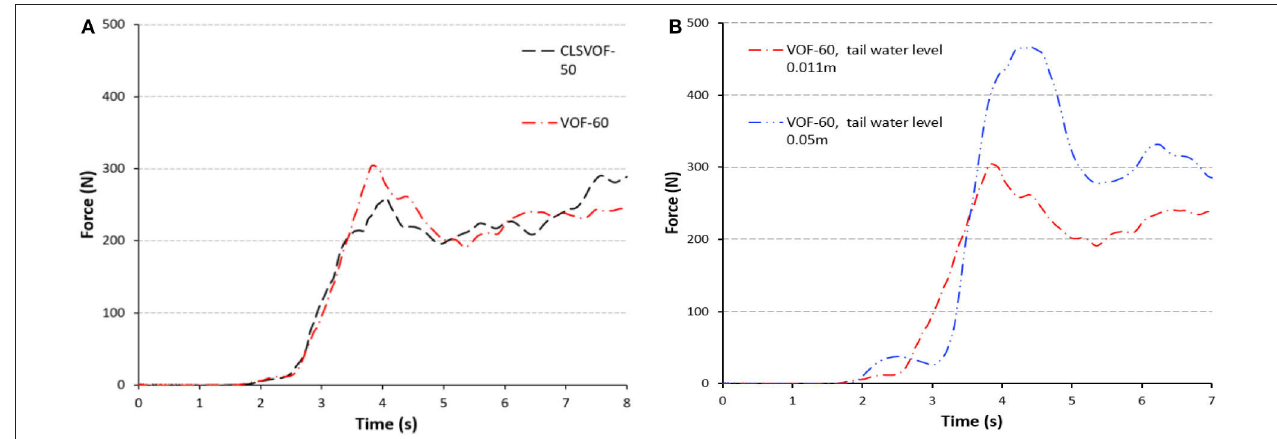
FIGURE 9 | (A) Evolution of x -force acting on the buildings using CLSVOF/IB and VOF/IB methods. (B) Evolution of x -force acting on the buildings using VOF/IB method with different tail water